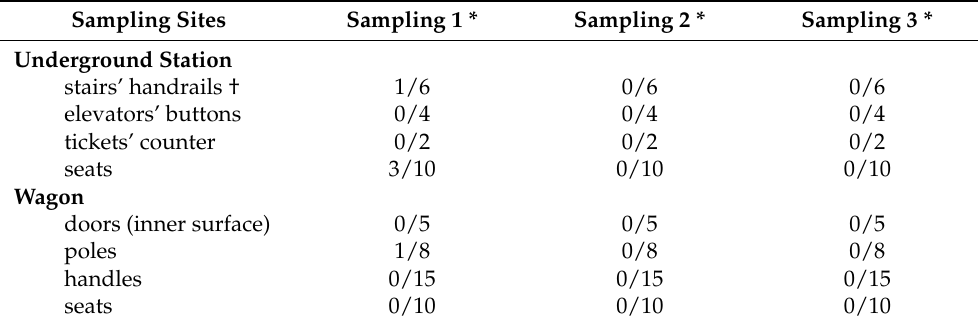
Table 3. Samples testing positive for SARS-CoV-2 by sampling site and phase, Athens metro. Sampling